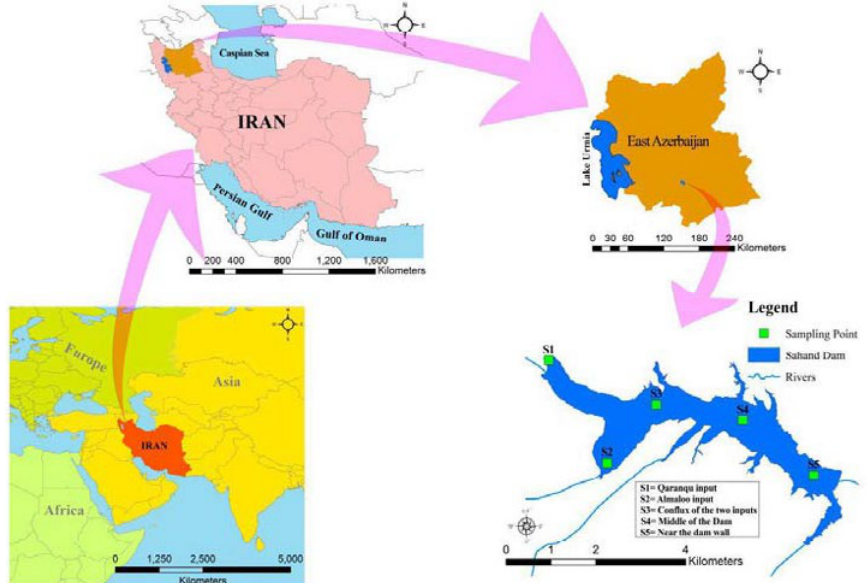
Fig. 1: Geographical location of the study area showing the sampling points